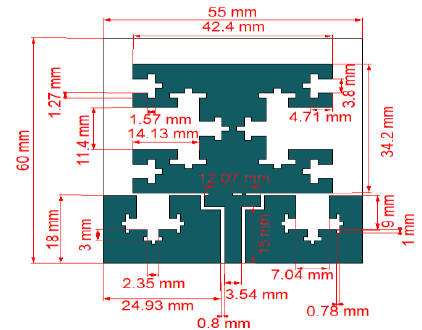
(e) 3 rd iteration with modified feed